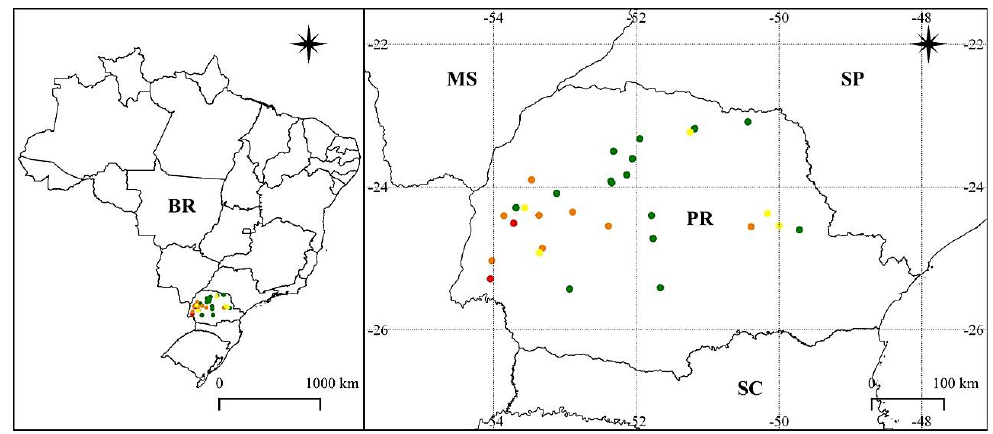
Figure 1. Dispersion of populations of Sumatran fleabane ( Erigeron sumatrensis ) resistant to ALS inhibitors, chlorimuron-ethyl, and cloransulam-methyl in Paraná state (PR), Brazil. Red: cross-resistance to ALS inhibitors; orange: resistant to chlorimuron-ethyl; yellow: resistant to cloransulam-methyl; green: susceptible.